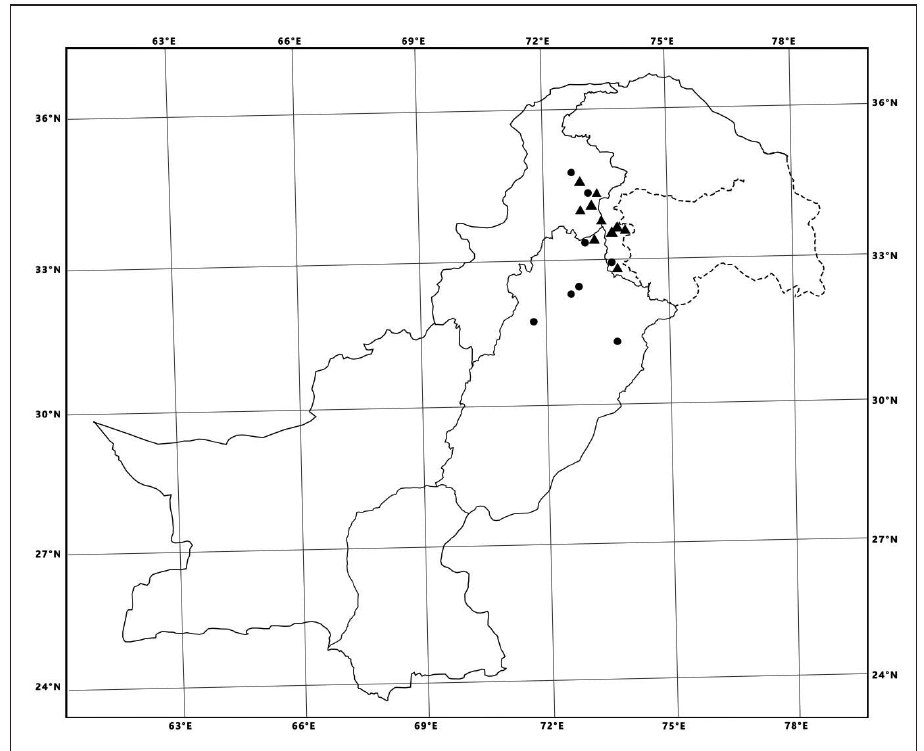
Figure 4. Distribution map: Scymnus ( Scymnus ) contortubus Rashid, Chen & Wang, sp. n. ( ▲ ) and Scym- nus ( Scymnus ) nubilus Mulsant ( ●